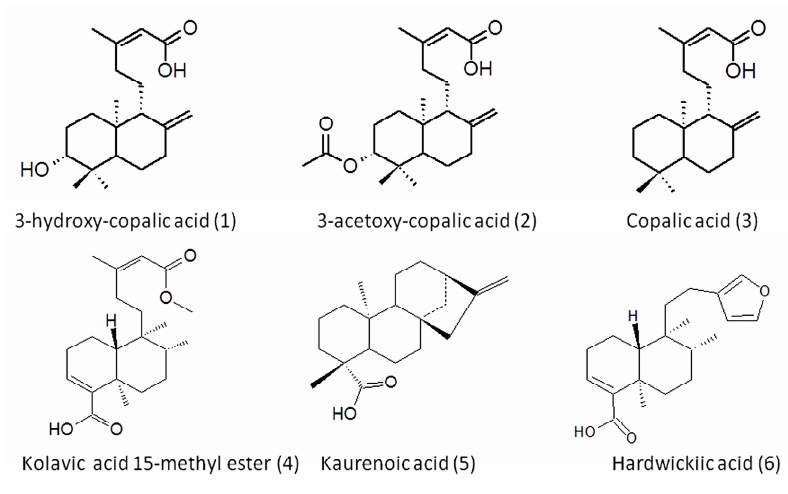
Figure 3. Chemical structures of diterpenes isolated from Copaifera